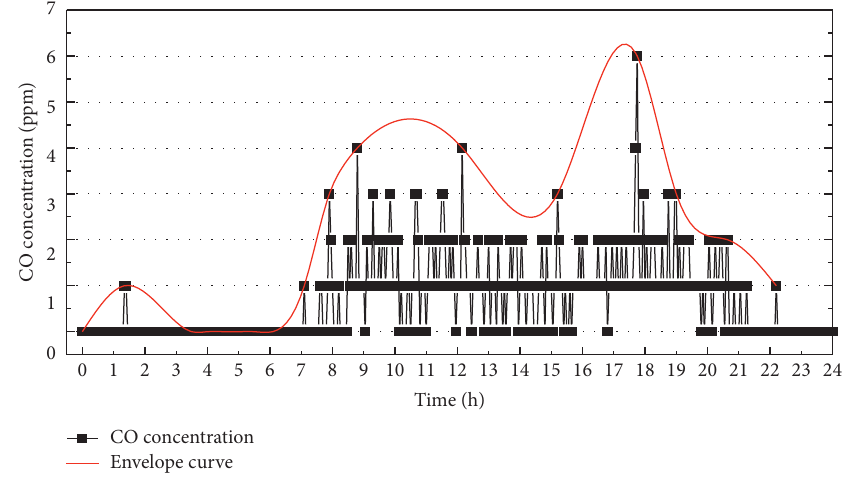
Figure 9: Diurnal profile of CO concentration in the left bore of Dameisha Tunnel (ZK1+335).